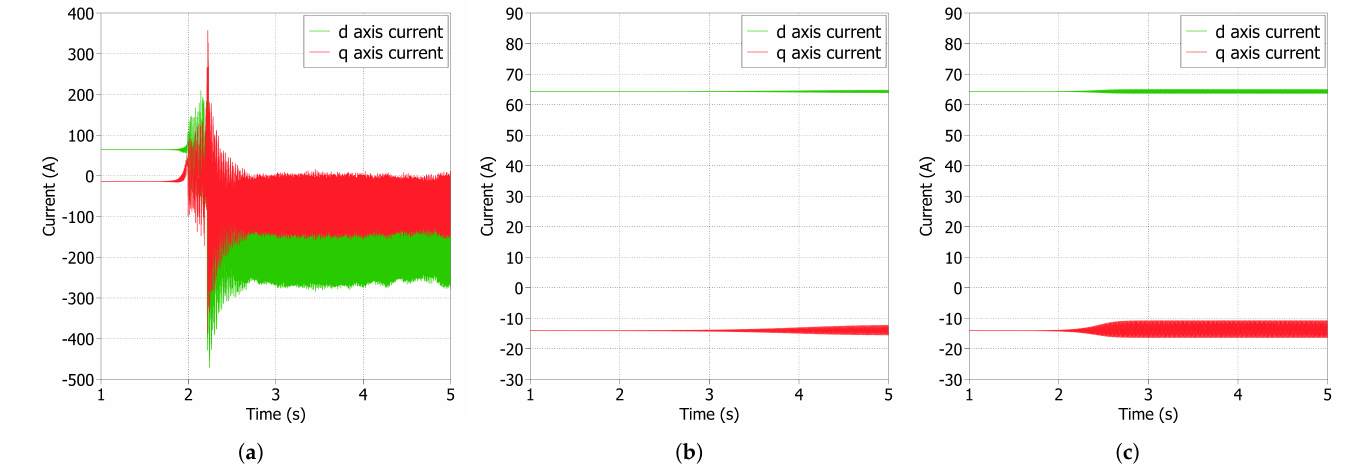
Figure 15. Time domain simulations of the VSC inductor current I L for different AVC filter cases. The stability impact of PLL in a weak grid (SCR = 1.5) was observed, caused after the step change in K P , PLL 0 to its critical value K P , PLLcr at t=1.5 s; ( a ) K P , PLLcr = 1.3094 when f AVC,LPF = 20 Hz;